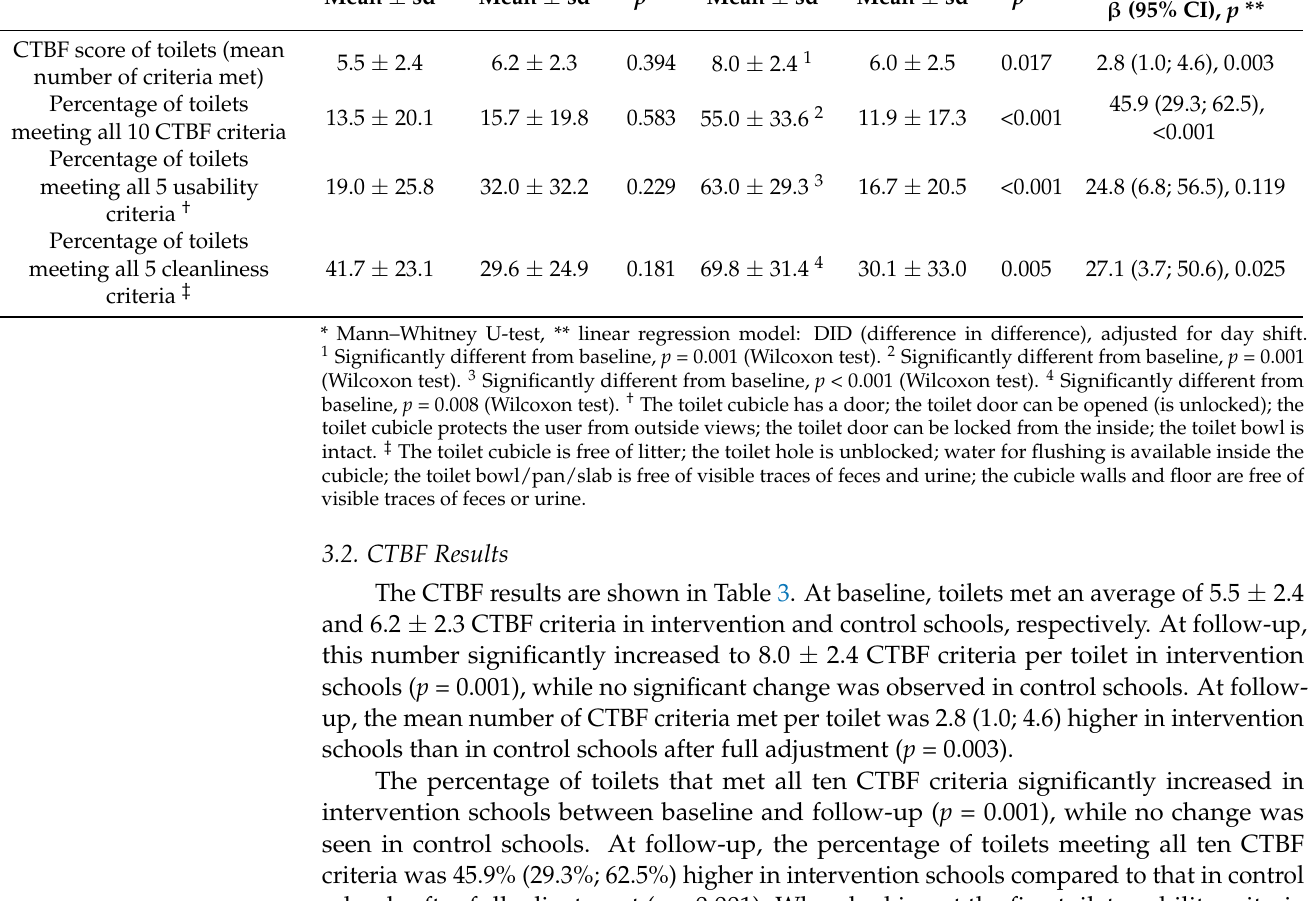
Table 3. Percentage of toilets meeting the CTBF criteria and mean CTBF scores of toilets in intervention and control schools at baseline and follow-up. Baseline Follow-Up Intervention